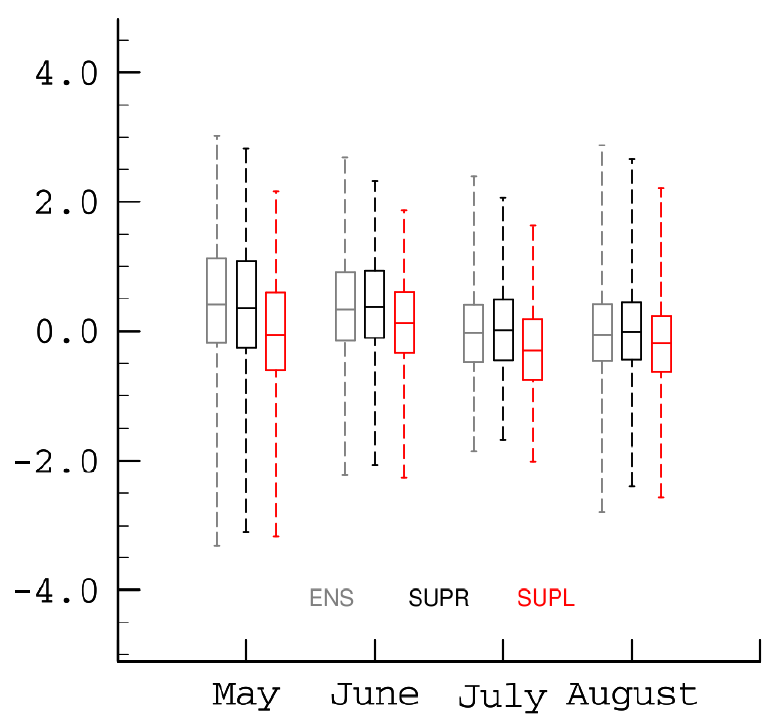
Figure 4. Box-and-whisker plot of MBE for the initial days from May to August derived from the ensemble forecast of ENS (grey), SUPR (black), and SUPL (red). The bounds of the box are at the 25th and 75th percentile, and the flat line in the box is the median. The whiskers represent the minimum and maximum values.